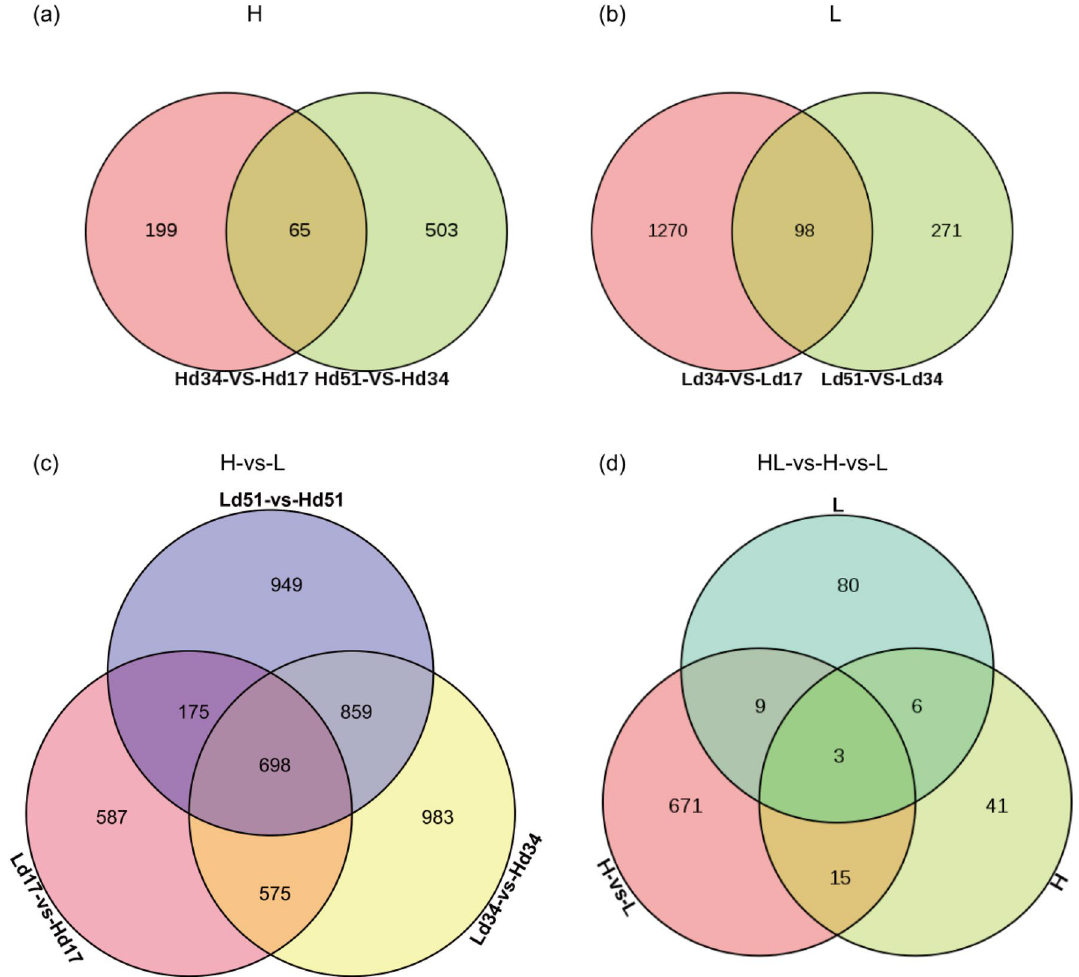
Figure 1. Venn diagrams of DEGs. ( a ) Venn diagram of DEGs during three cultivation periods of high-yielding strains; ( b ) Venn diagram of DEGs during three cultivation periods of the low-yielding strains; ( c ) Venn diagram of DEGs between high-yielding and low-yielding strains in three culture periods; ( d ) Venn diagram of DEGs in high-yielding strains, low-yielding strains, between high- and low-yielding